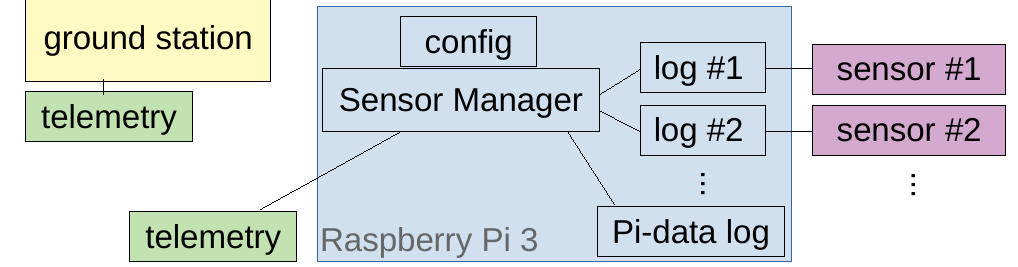
Figure 6. Schematic software setup of the sensor system on-board